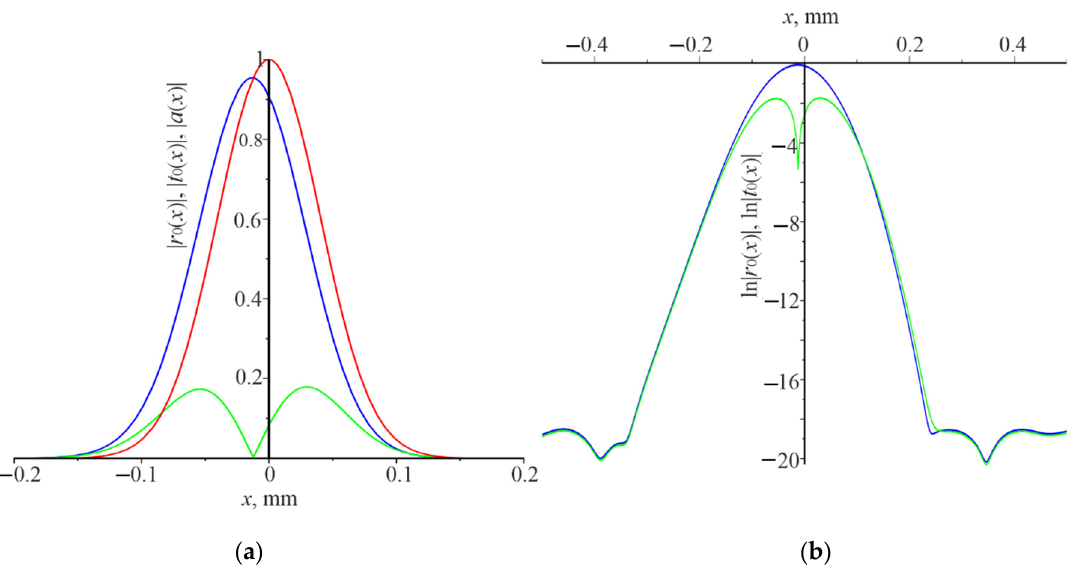
Figure 5. The distribution of the field amplitude along the x coordinate of the incident Gaussian beam | a ( x )| (red curve), reflected beam | r 0 ( x )| (blue curve), the transmitted beam | t 0 ( x )| (green curve) ( a ). ln| r 0 ( x )| (blue curve), ln| t 0 ( x )| (green curve) ( b ). Numerical calculations were carried out under the conditions d = 0.32 µ m, λ = 1.17 µ m, θ = π /18, L = 0.1